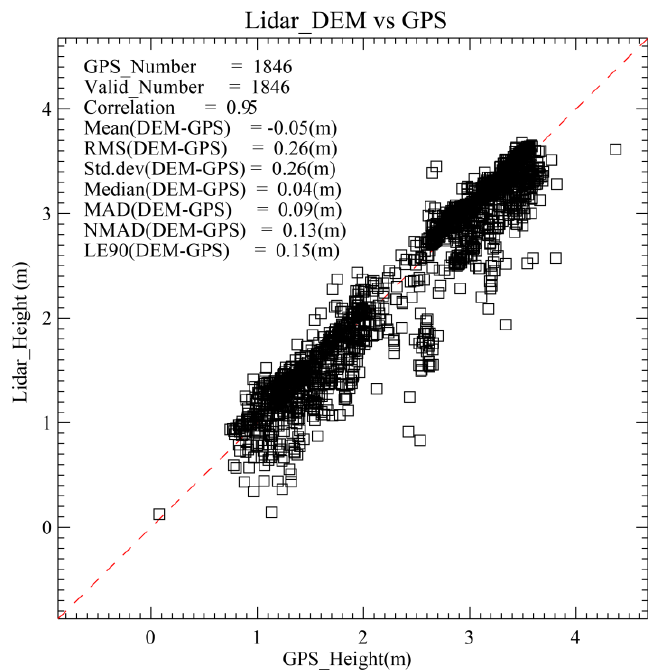
Figure 10. Correlation between detailed points collected by GNSS RTK and LiDAR DEM. The number of points utilized in the assessment was 1846.